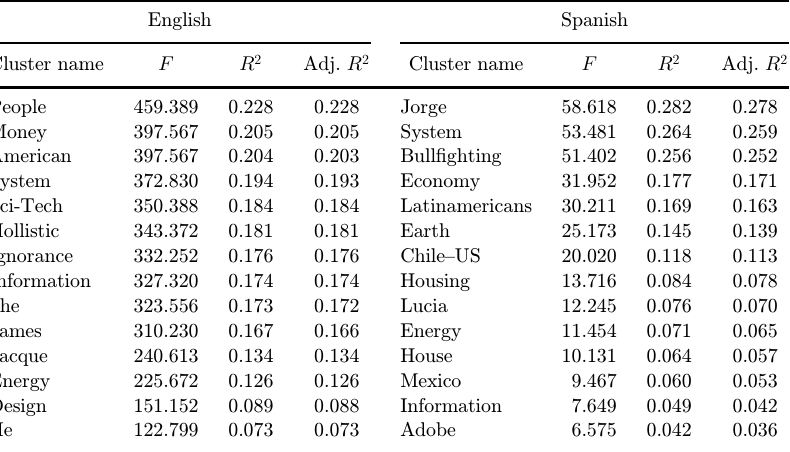
Table 1. Regression analysis for top word clusters and